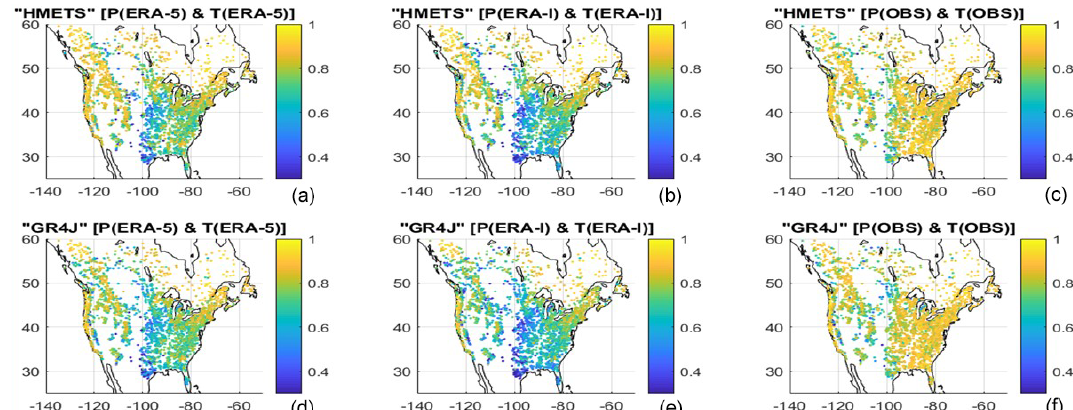
Figure 5. Spatial distribution of Kling–Gupta efficiency metrics for all 3138 watersheds for the HMETS model (a, b, c) and GR4J model (d, e, f) , and for ERA5 (a, d) , ERA-I (b, e) and observations (c, f) .